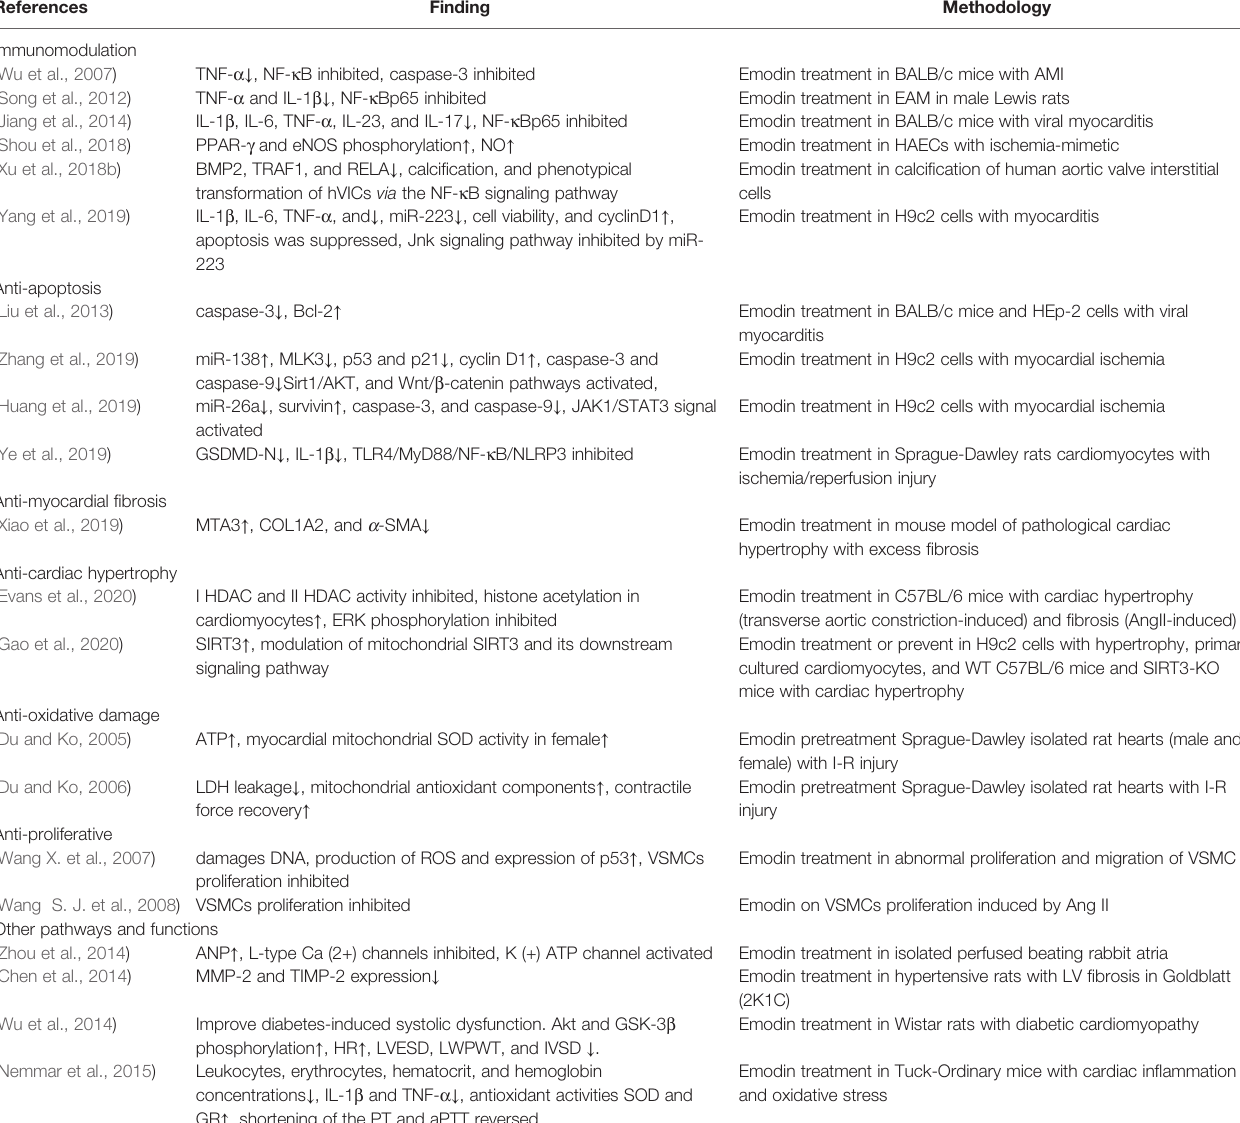
TABLE 1 | Pharmacological effects of emodin in anti-cardiovascular